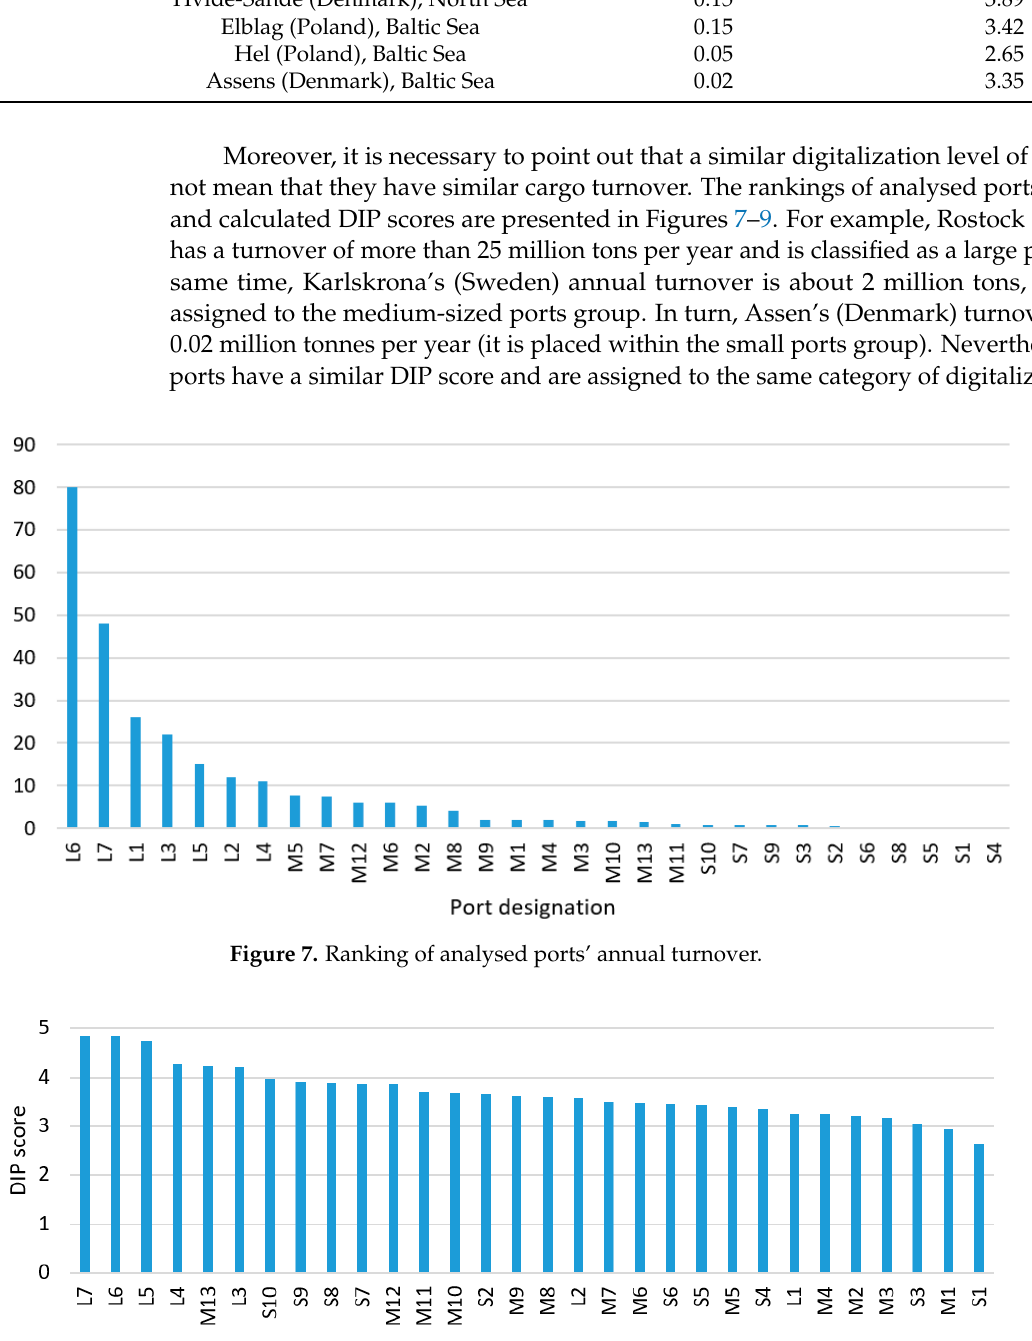
Figure 9. Ranking of analysed ports’ turnover and DIP score. On the basis of the results analysis it was observed that, within analysed groups of ports, seaports with lower cargo turnover have less possibilities of digitalizing port oper- ations and other activities. This may be due to the limited financial support and volume of investment for digitization. 5. Discussion and Conclusions As the result of the conducted research, a methodology to evaluate the level of a port’s digitalization has been proposed and its verification in the selected case study anal- ysis was carried out. It was proposed to apply a DIP score to assess ports’ digitalisation levels. A mathematical model was proposed for data analysis. Thirty European seaports with different cargo turnovers were evaluated using the developed approach. Presented methodology could be applied in practice to evaluate ports’ digitalization levels for small, medium-sized and large ports. The results may also be used by ports, terminals or other entities for comparative analysis. The presented approach and imple- mentation makes it possible to assess the current state of ports’ digitalization level which may allow information on the areas of a ports’ activity that need further improvement. Moreover, the proposed approach may be used as a basis for benchmarking and allow